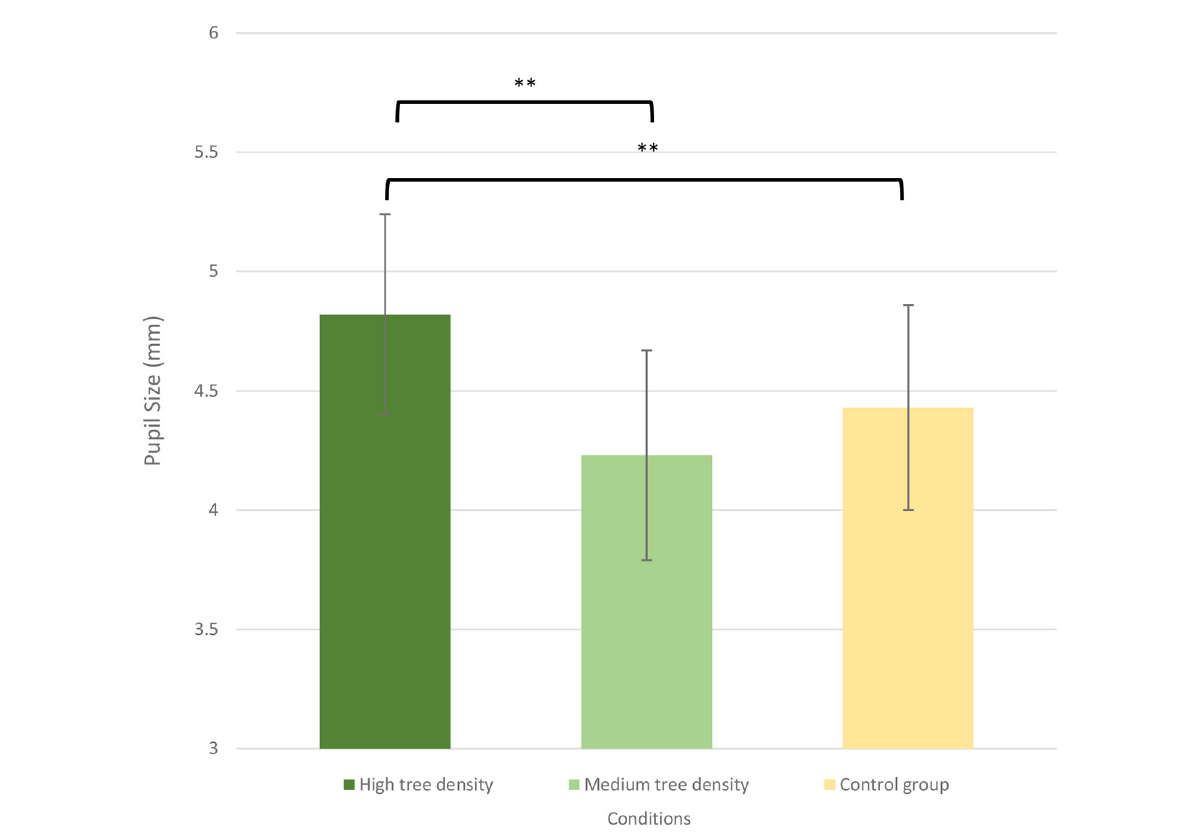
FIGURE5 Pupil size for the high tree density sportscape (HTDS) and the medium tree density sportscape (MTDS) groups during exercise. (** p <